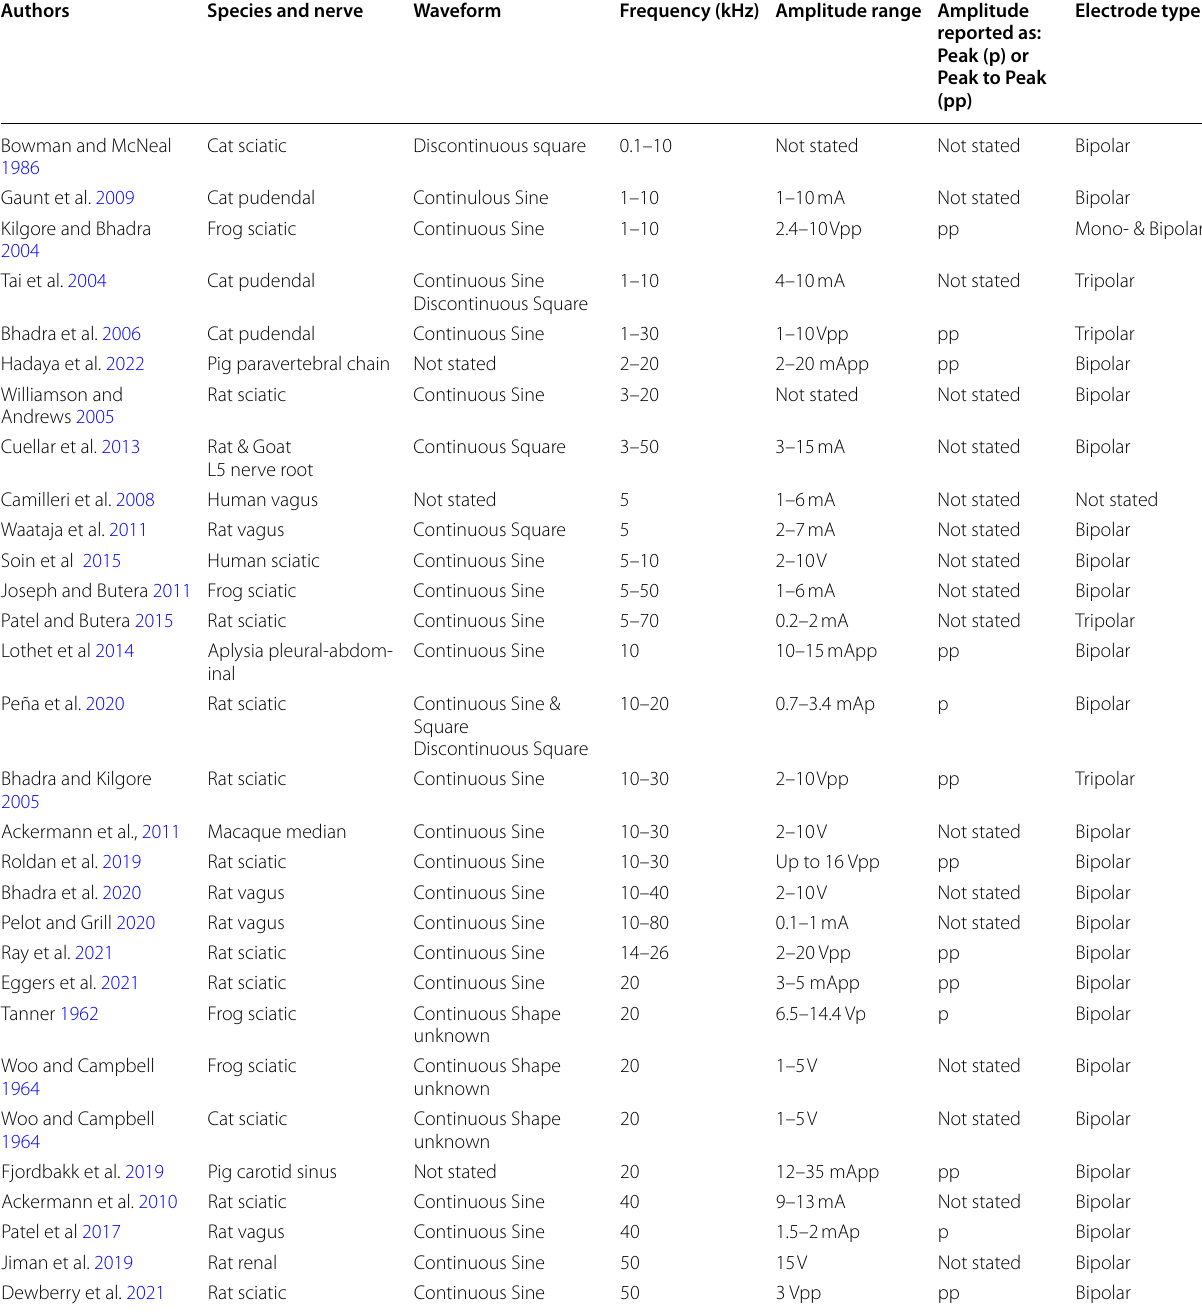
Table 1 Summary of experimental KHFAC block in the literature. A majority of studies did not state whether amplitudes were peak or peak to peak. The table is arranged in ascending order of frequency